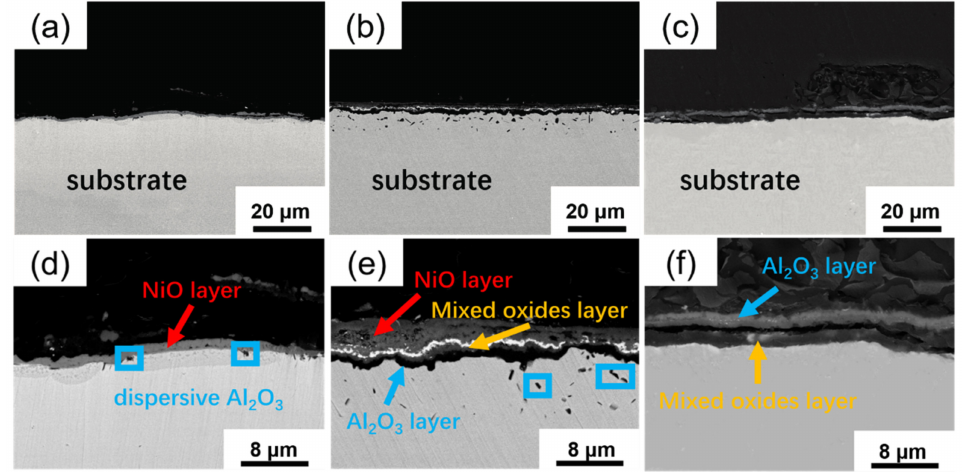
Figure 3. The cross-section structures (BSE images) of prefabricated oxidation layer for di ff erent alloys: ( a , d ) Alloy 1, ( b , e ) Alloy 2 and ( c , f ) Alloy